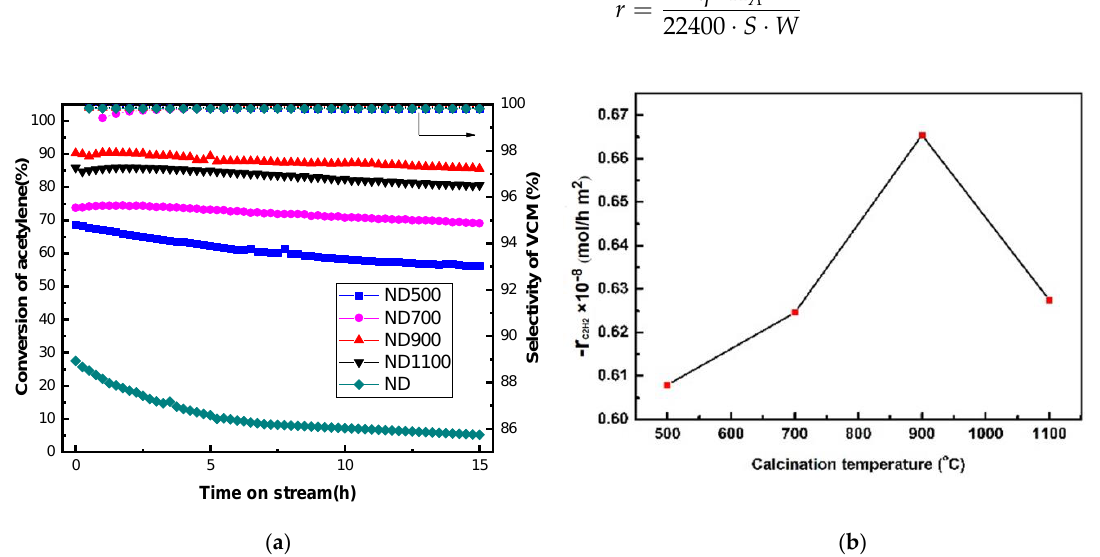
Figure 4. ( a ) Acetylene conversion and selectivity on the ND, ND500, ND700, ND900, and ND1100 catalysts. ( b ) The relationship between the calcination temperature and reaction rate per surface area.